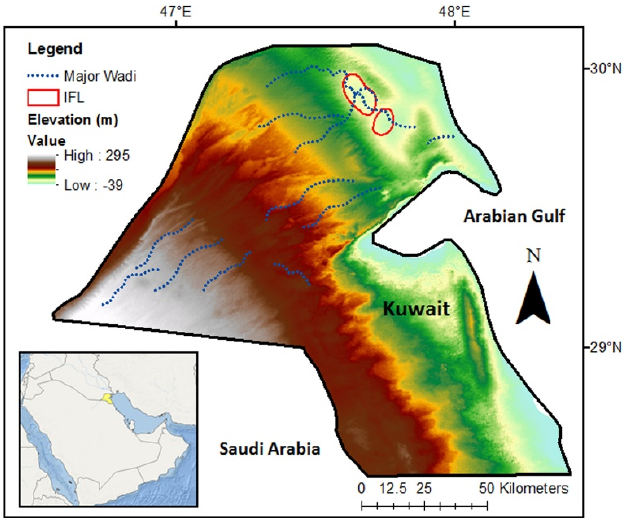
Figure 2. Map of Kuwait showing the location of the Raudhatain (top) and Umm Al-Aish (bottom) IFLs highlighted in red.